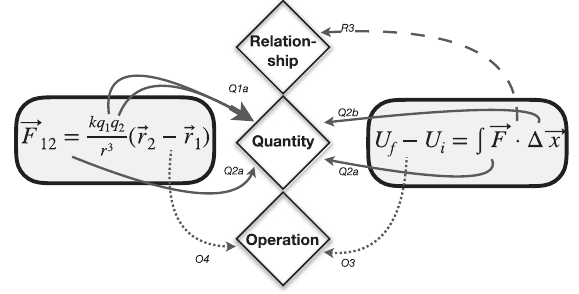
FIG. 1. Compound use of negative signs typical of introductory physics:Coulomb ’ s law,theforceonobject 2 throughits interaction with object 1 (left), and the work-energy theorem